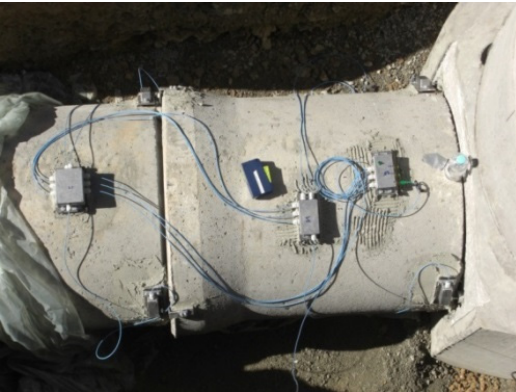
Figure 12. Example of a quasi-distributed FBG sensor network that was developed for the SHM of sewerage tunnels. Reprinted with permission from ref. [68]. Copyright 2016 Procedia Technology.